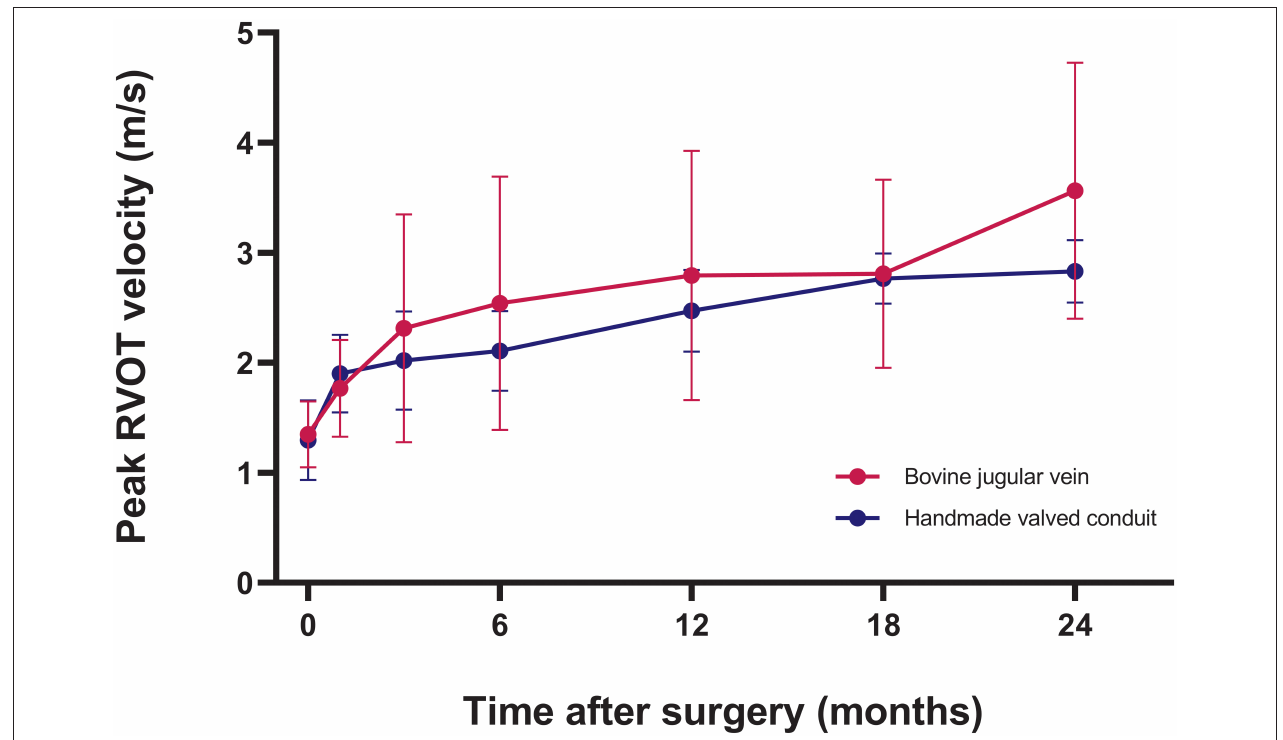
FIGURE 3 | Graphic showing postoperative trend of peak right ventricular outflow tract (RVOT) velocity in two types of